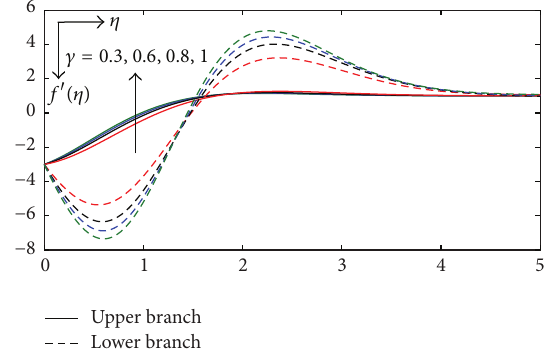
Figure 11: Velocity profiles for various values of 𝛾 with 𝑠 = −3 , 𝜆 = 0.5 , 𝑀 = 0.2 , and Pr = 3 .